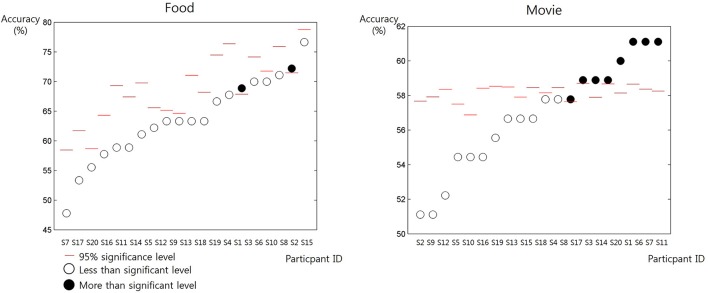
The accuracy of the prediction of others' preference in individual participants (from S1 to S20) for the items in the two categories: food and movie. The red bars denote the chance level of prediction accuracy estimated from the behavior data of individual participants. The white circles denote the resulting prediction accuracy of individual participants lower than the chance level. The black circles denote the resulting prediction accuracy of individual participants higher than the chance level.